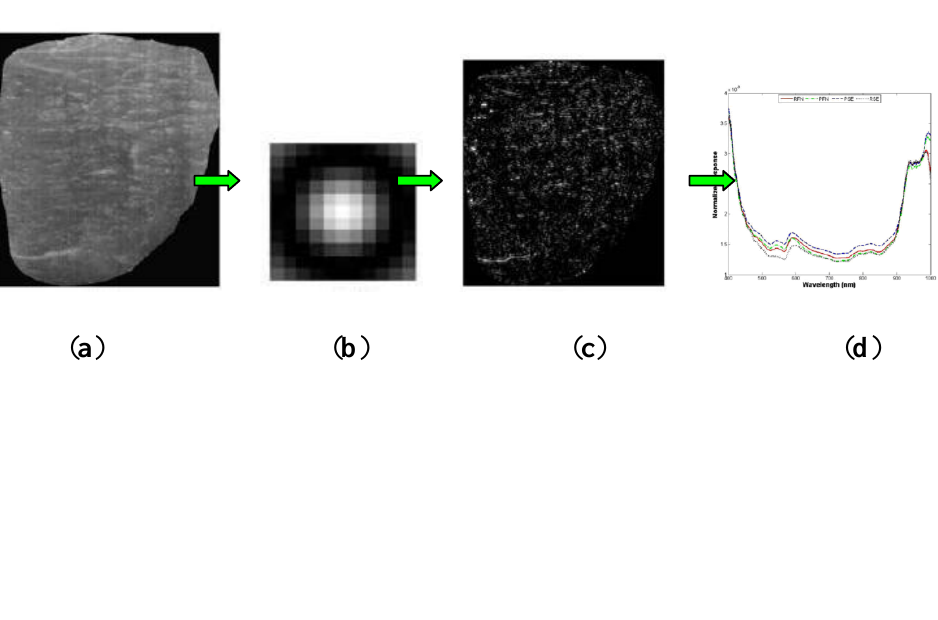
Figure 6. Gabor filter for extracting texture features from a ROI of a pork image. ( a ) Selected ROI of pork, ( b ) applied Gabor filter, ( c ) Gabor filtered image, ( d ) extracted texture